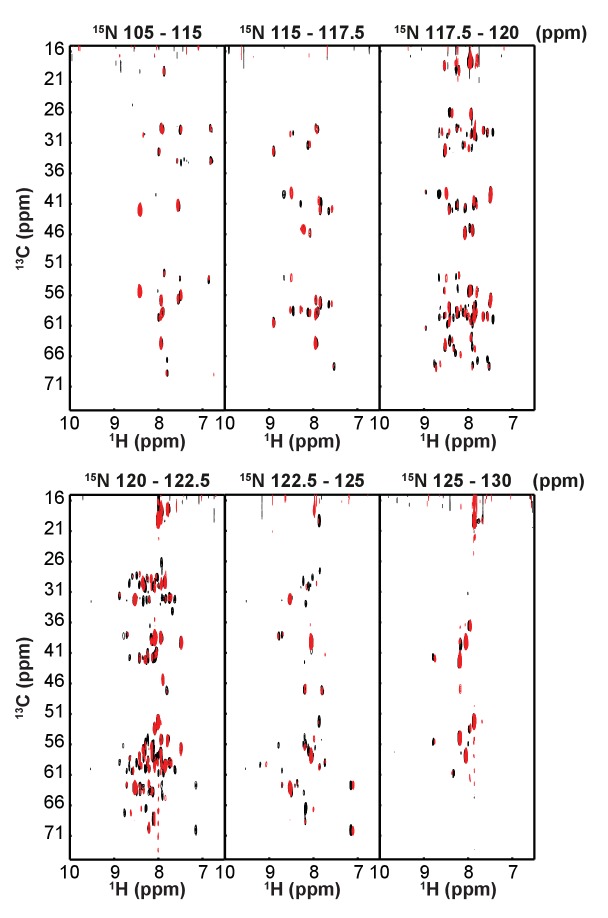
CBCACONH data of wild-type and CMut Bag-1L.Superposition of CBCACONH of Bag-1L WT (black) and the K231/232/279A mutant (Bag-1L CMut; red). 1H 13C planes were extracted from the 3D spectrum at the indicated 15N values.